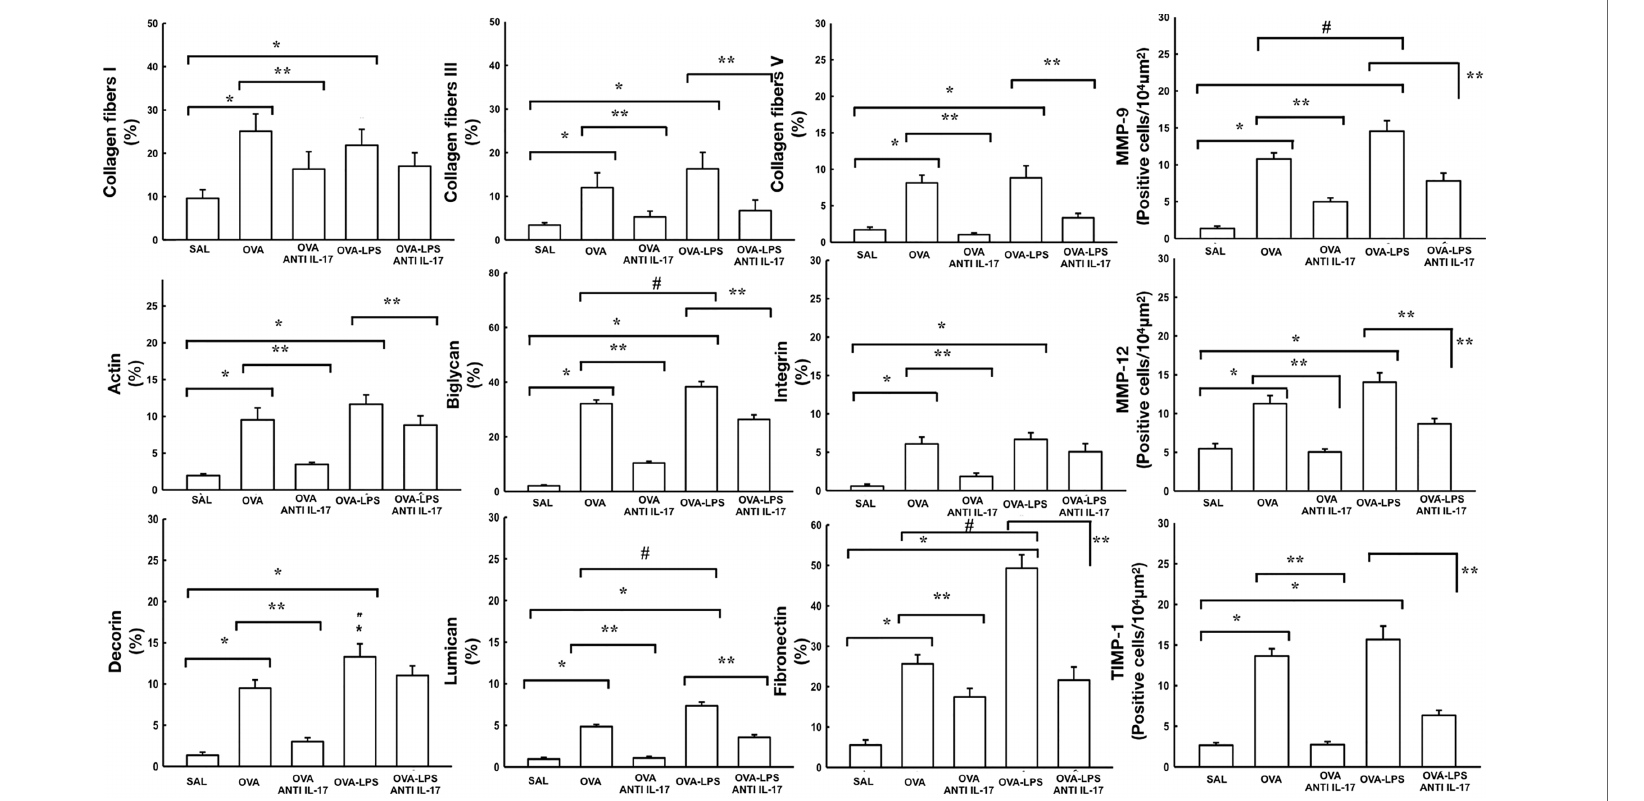
FIGURE 3 | Effects of anti-IL 17 treatment on vascular remodeling. The values represent the mean ± standard error (SE) of the collagen fi bers I, III, V, MMP-9, actin, biglycan, integrin, MMP-12, decorin, lumican, fi bronectin, and TIMP-1 for all experimental groups. The differences were considered signi fi cant when p<0.05. *p<0.05 vs. SAL group; **p<0.05 vs. OVA and OVA – LPS groups. # p<0.05 vs. OVA group.